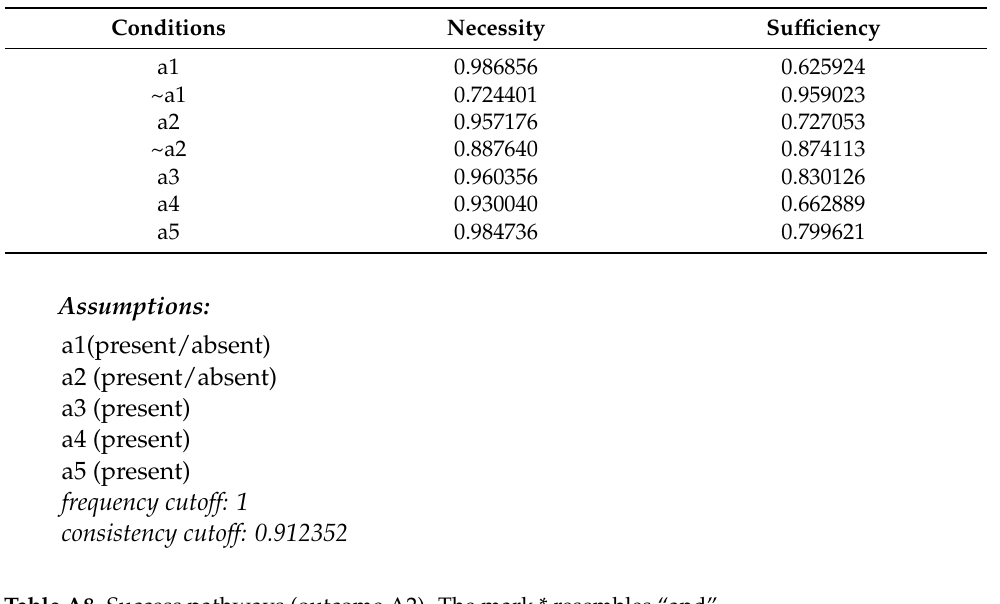
Table A7. Necessity and sufficiency analysis of conditions (outcome A2).